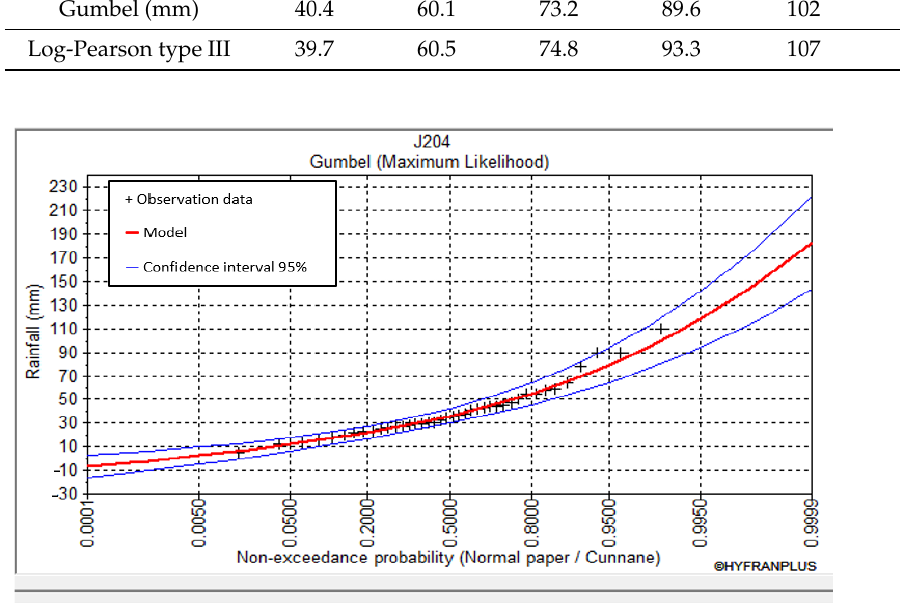
Figure 3. Gumbel fit of maximum daily rainfall of J204 station.